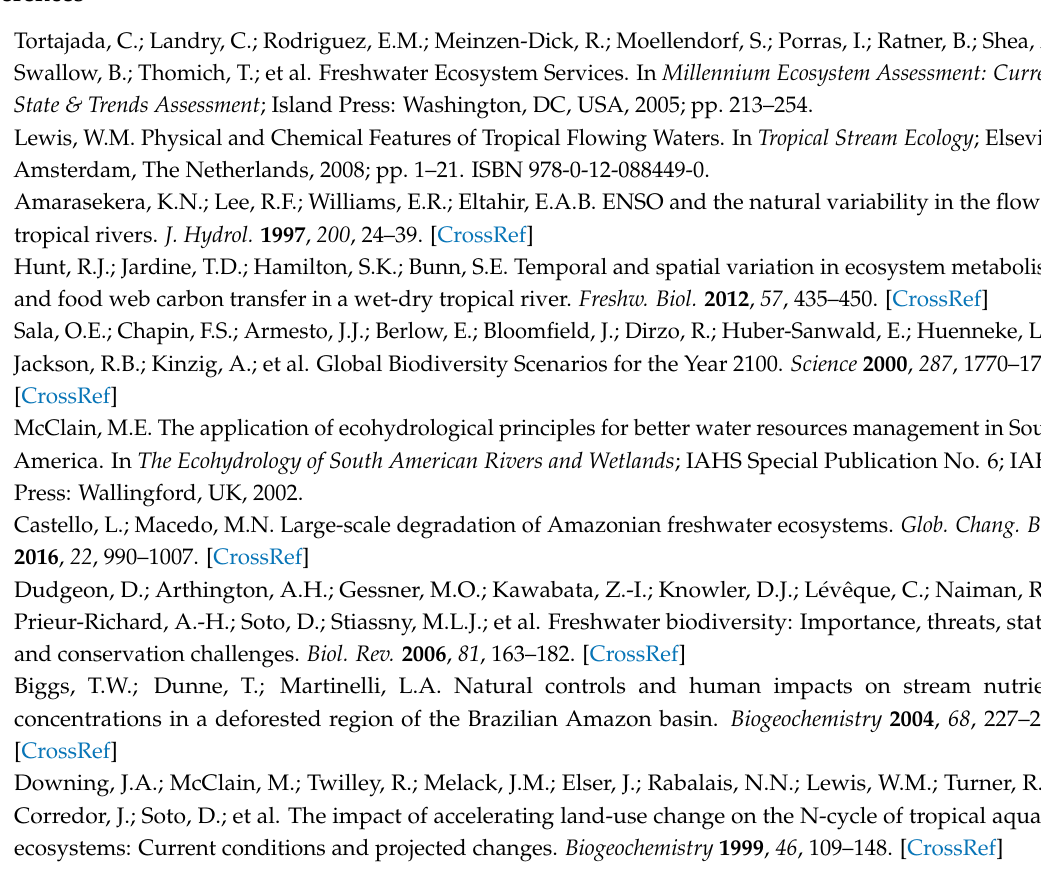
Table S1: In-stream nutrient concentrations for the four study